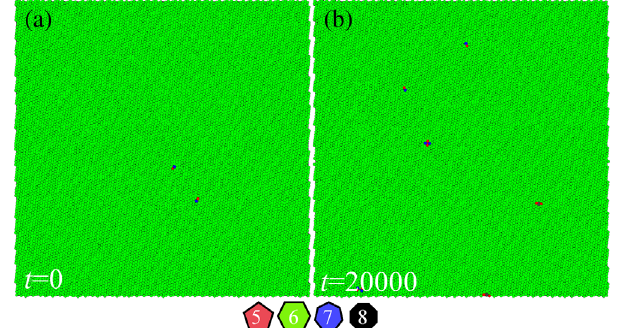
FIG. 11. The Voronoi diagrams of the single crystal at ϕ ¼ 0 . 62 and T ¼ 0 . 133 U 0 =k . Five-neighbor particles (red) and seven- B neighbor particles (blue) form pairs, i.e., dislocations [64], which can easily diffuse under this temperature, as shown in (a) t ¼ 0 and (b) t ¼ 20 000 t 0